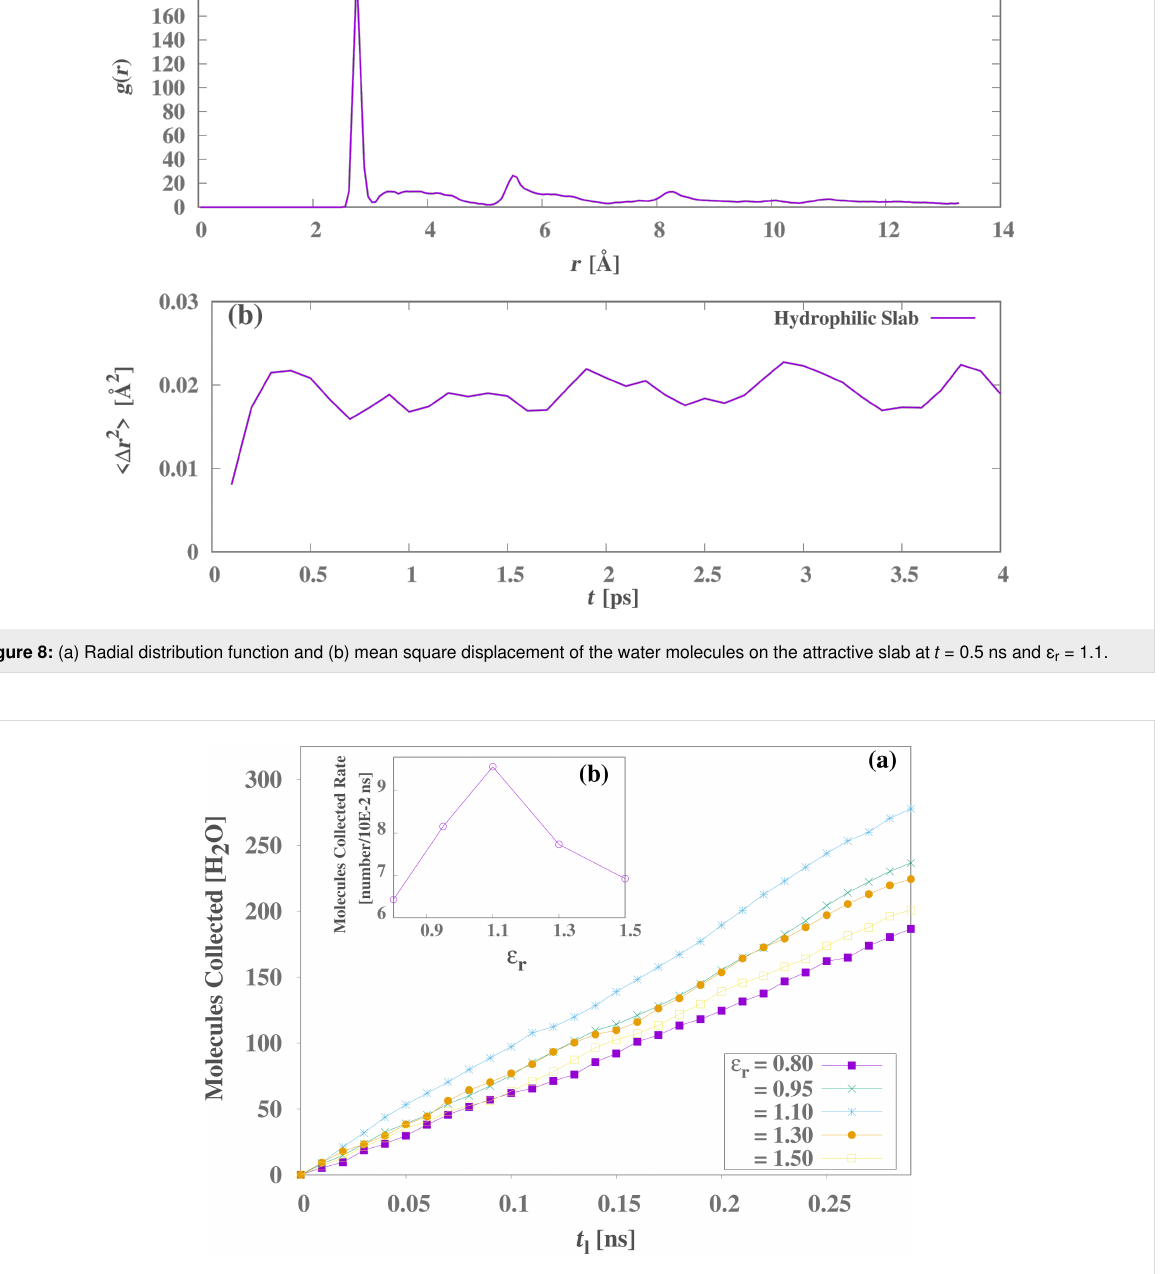
as a function of time for different values of water–wall attrac- tion, that is, ε r = 0.80, 0.95, 1.1, 1.3, and 1.5. Each line is aver- aged over five samples. Note that the slopes of lines for fixed ε r present a non-monotonic behavior with ε r . In order to under- stand the impact of varying attraction, we calculated the mean collected rate of molecules (MCR) per unit of time (10 − 2 ns), using